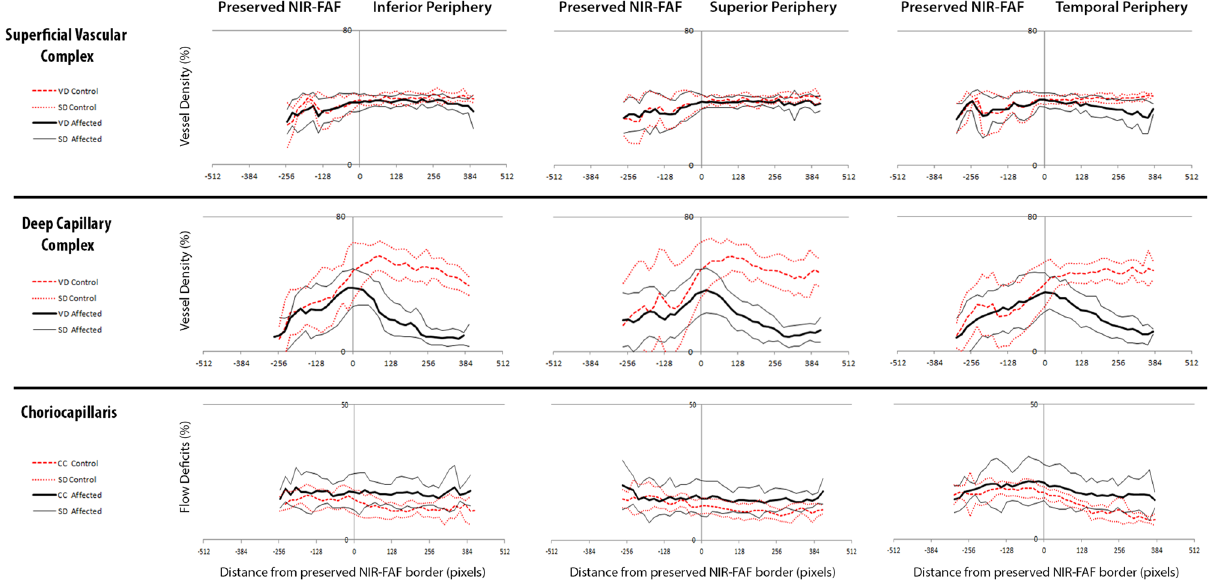
Figure 7. Vessel density (VD) and flow deficits (FD) profiles in patients with retinitis pigmentosa and age- matched controls, analyzed in three vascular layers, in three directions: superior, inferior and temporal from the fovea. The “0” on the x-axis corresponds to the border of the preserved near infrared fundus autofluorescence (NIR-FAF).